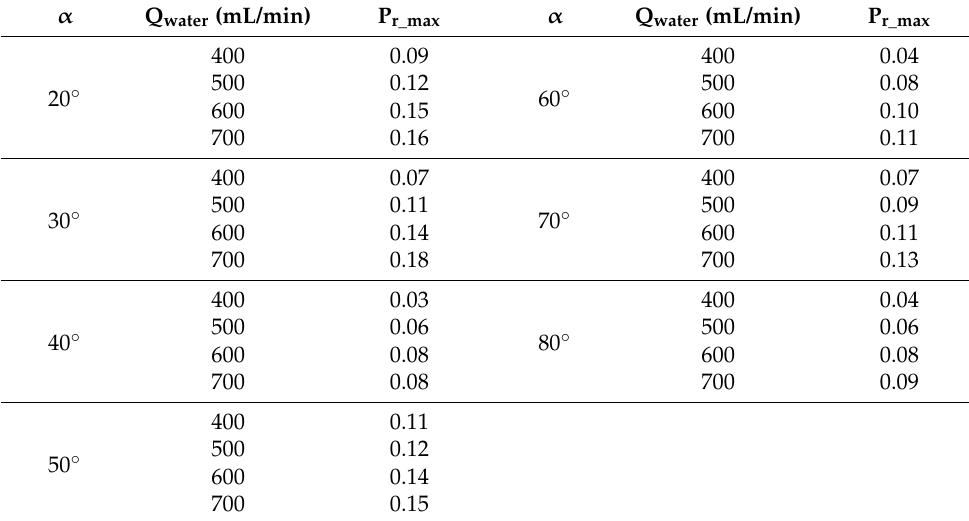
Table 1. Maximum pressure ratio (P r_max ) according to the diverging angle ( α ) and water flow rate (Q water ).